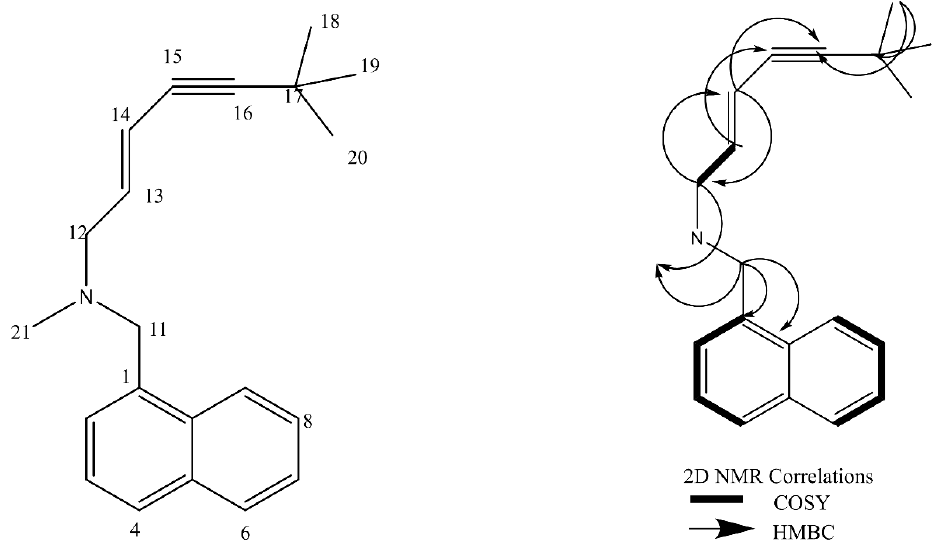
Figure 5. Chemical structure of the active metabolite produced by Lysinibacillus isolate MK212927 based on the spectral data showing 1 H NMR, 13 C NMR signals assignments and 2D NMR (COSY, HMBC) correlations.